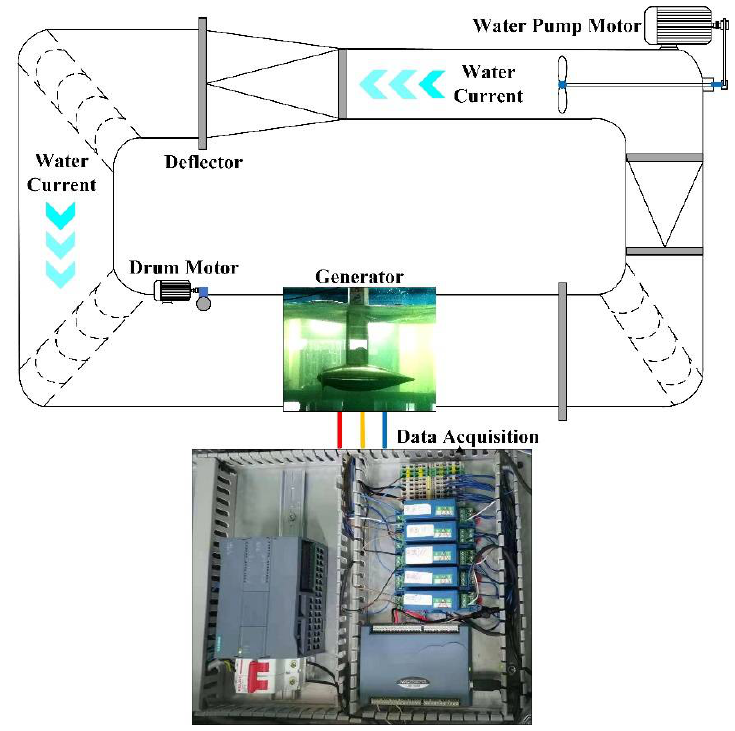
Table 1. Specific parameters of MCT in the experiment.